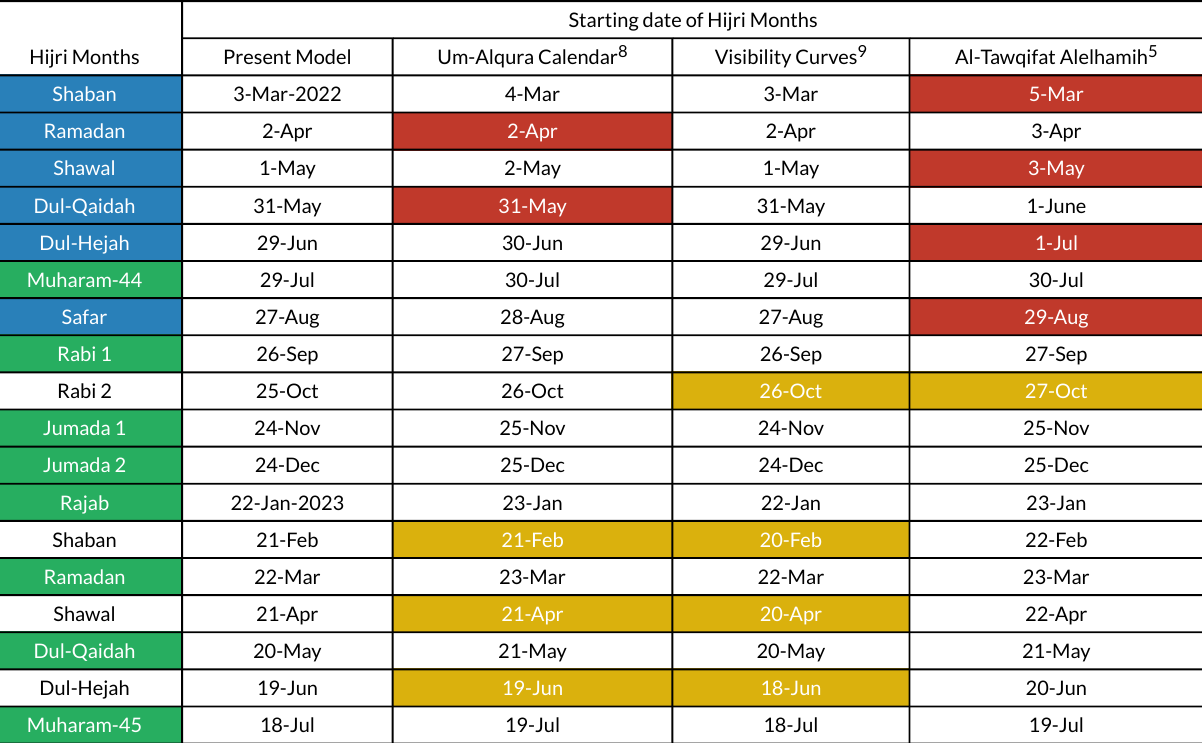
Table 2. The results comparison of the present model Vs 3